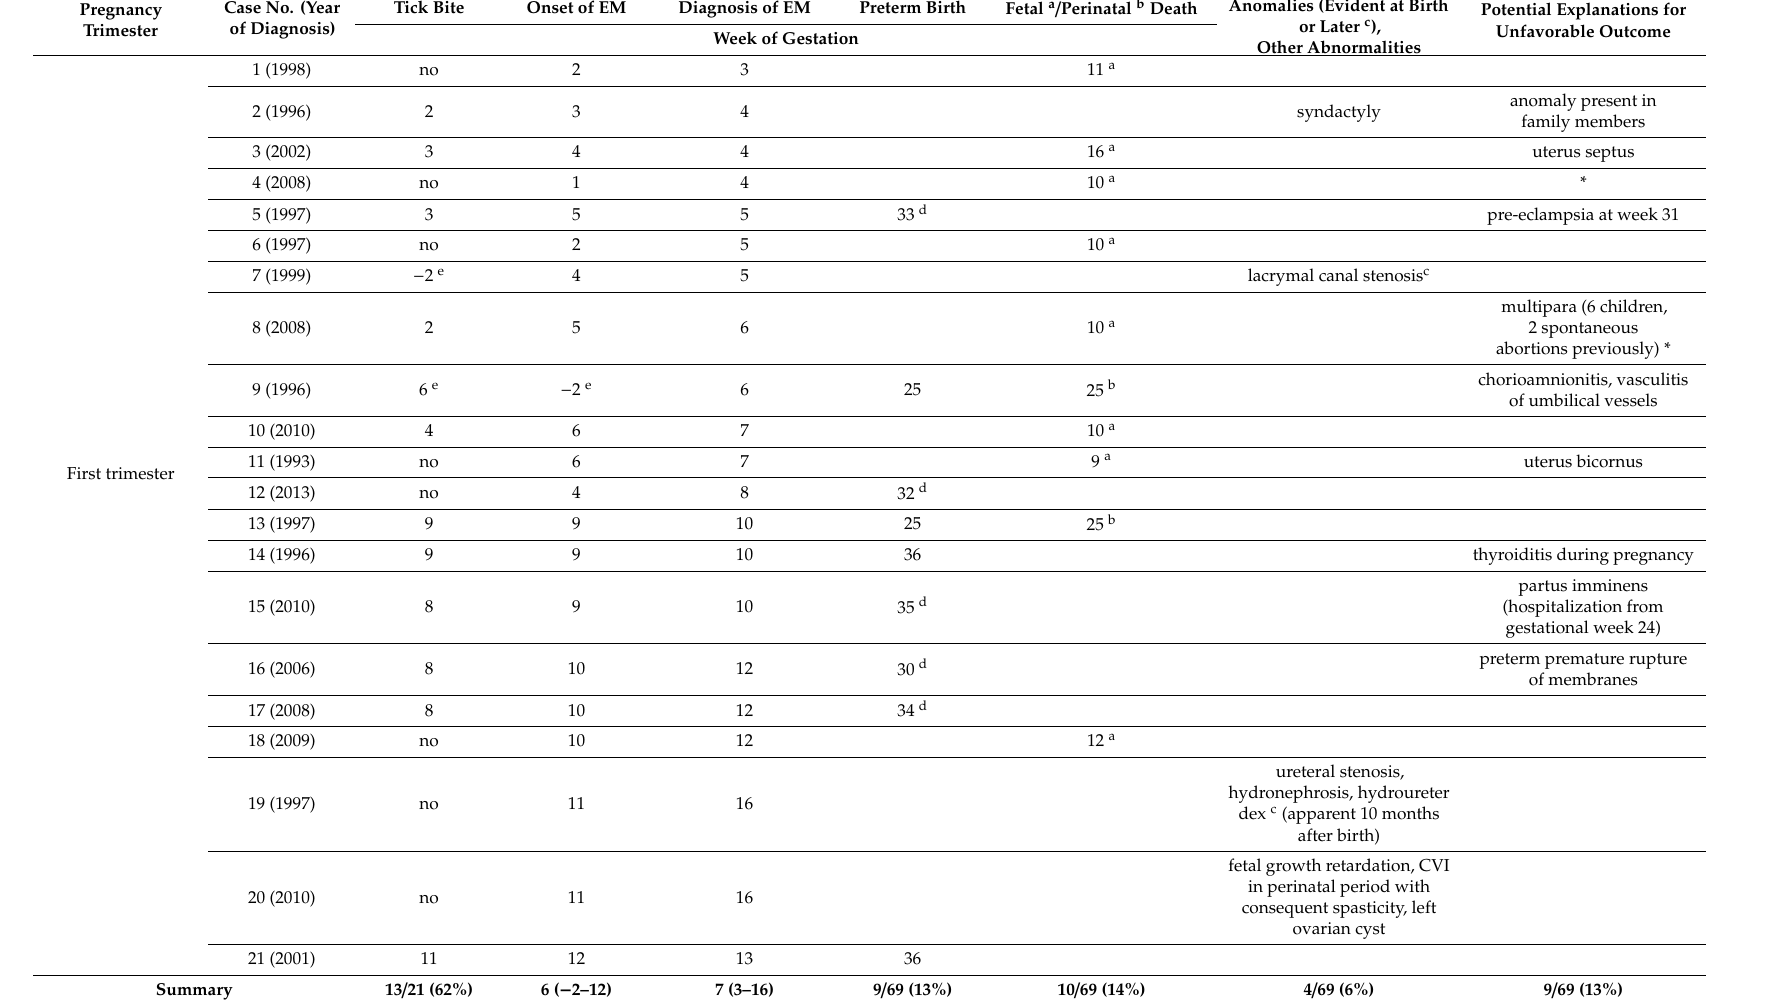
Table 2. Unfavorable outcome of pregnancy in 42 patients after antibiotic treatment of erythema